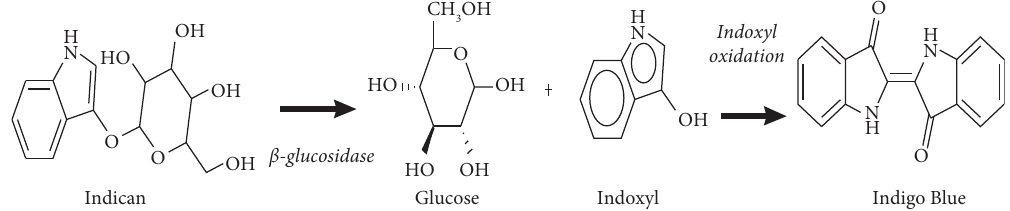
Figure 2: Conversion of indican precursor into